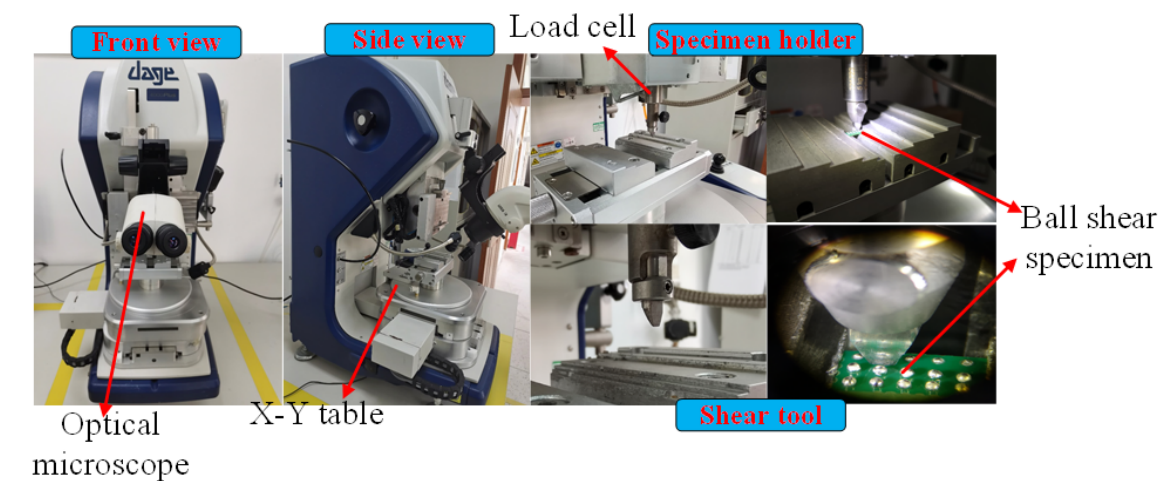
Figure 2. Ball shear test equipment, testing fixture, and shear tool.